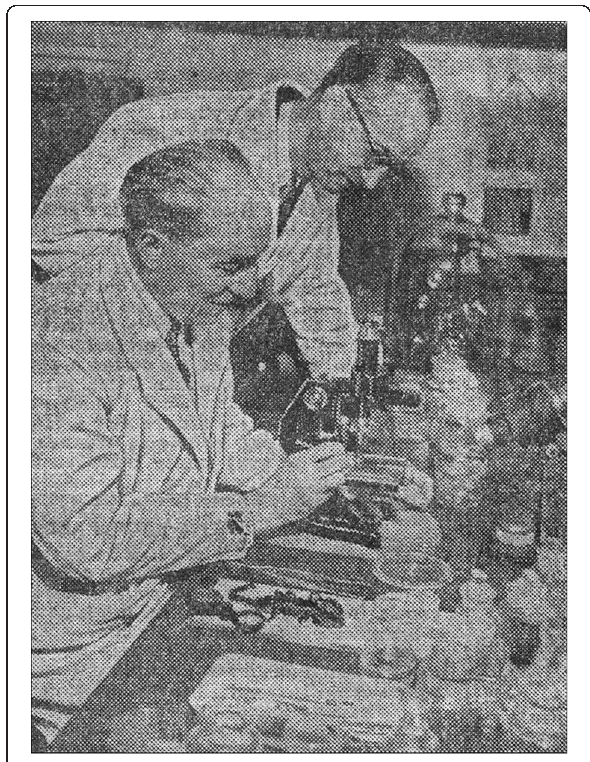
Figure 1 Very old photo showing Louis Fage (seated) and Max Vachon (standing behind him), examining scorpions in the National Museum of Natural History, Paris. Photo published in the newspaper Le Figaro Litteraire on July 19,